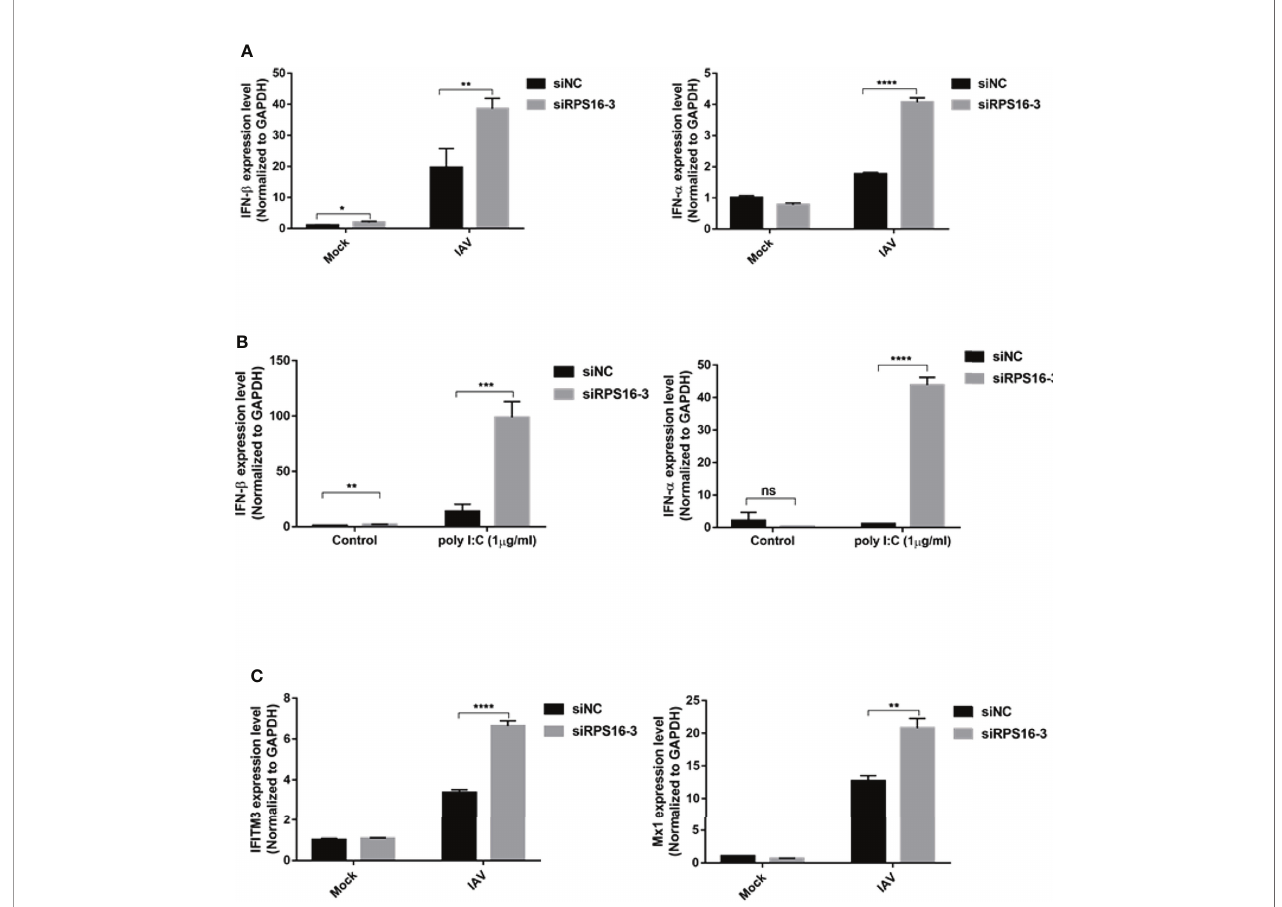
FIGURE 6 | RPS16 is a type I IFN repressor during virus infection. A549 cell was transfected with siRNA speci fi c to RPS16 (siRPS16) or negative control (siNC). (A) At 48h post transfection, the cells were infected with in fl uenza A/WSN/1933 virus at 1 of MOI for 12h, the expression of IFN- b and IFN- a were detected by real- time qPCR and normalized to expression of GAPDH; (B) At 48h post transfection, the cells were transfected with poly I:C (1µg/ml) for 12h, the expression of IFN- b and IFN- a were detected by real-time qPCR and normalized to expression of GAPDH. (C) At 48h post transfection, the cells were infected with in fl uenza A/WSN/ 1933 virus at 1 of MOI for 12h, the expression of IFITM3 and Mx1 were detected by real-time qPCR and normalized to expression of GAPDH. Data were shown as mean ± SD (* p < 0.05, ** p < 0.01, *** p < 0.001). Data are the representative of three independent